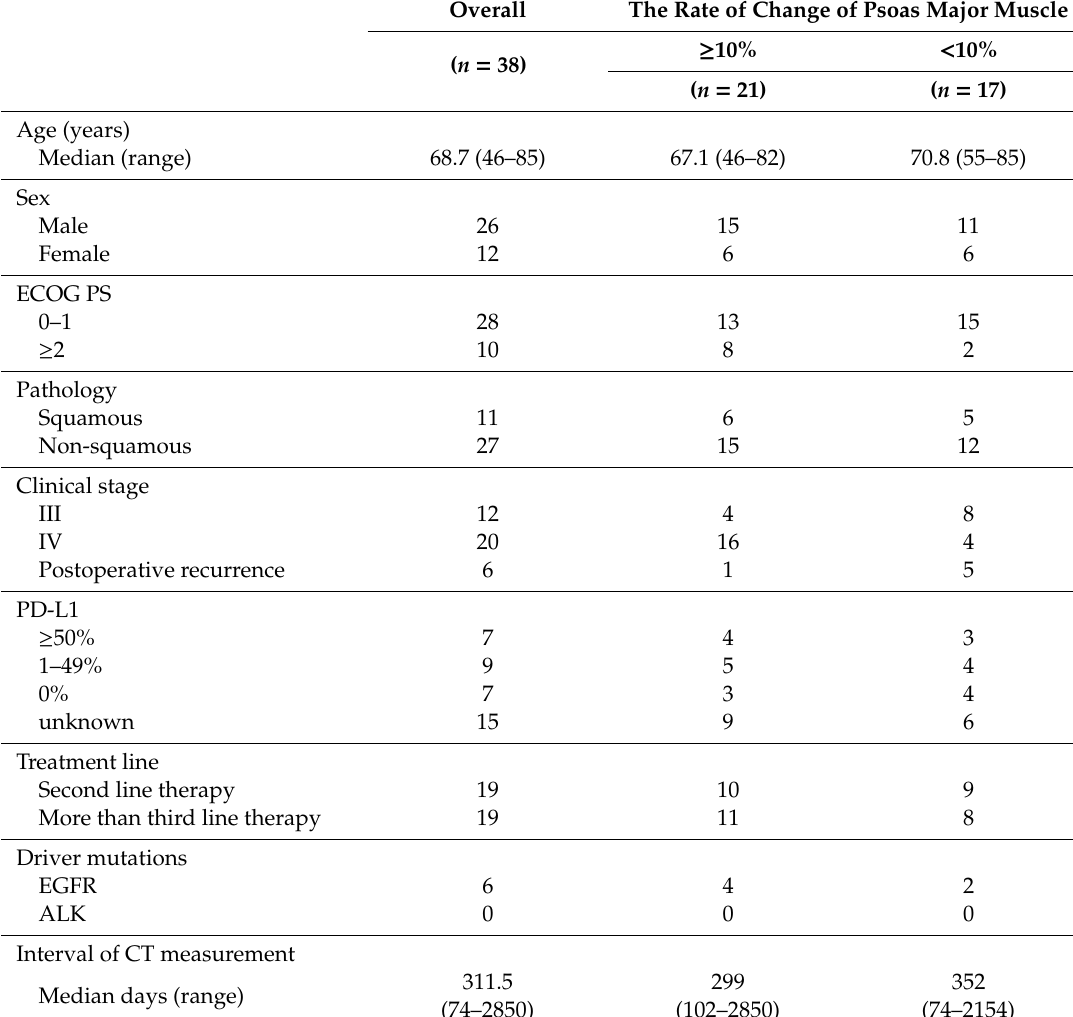
Table 1. The baseline characteristics of the